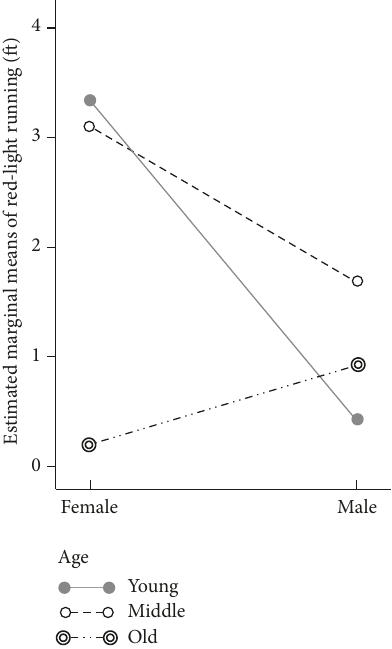
Figure 2: Two-way interaction between gender and age influencing red-light